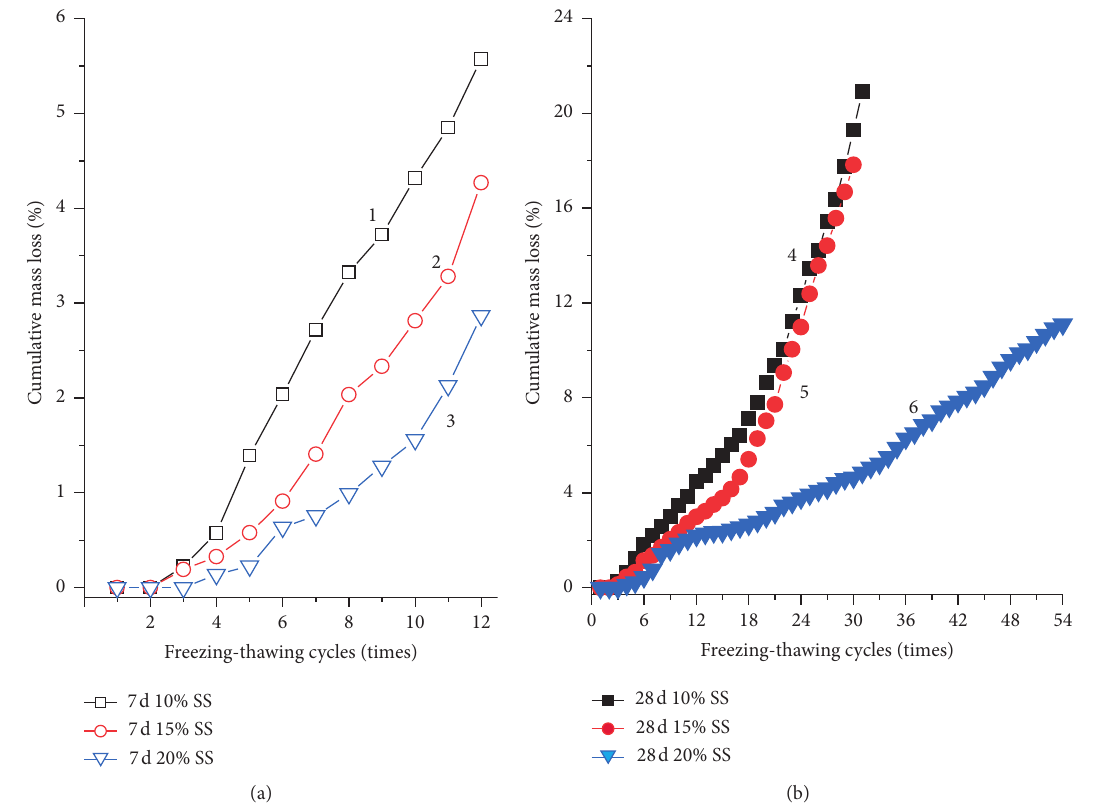
Figure 2: Cumulative mass loss of specimens with curing periods of 7 days (a) and 28 days (b) in Test I (SS means soil